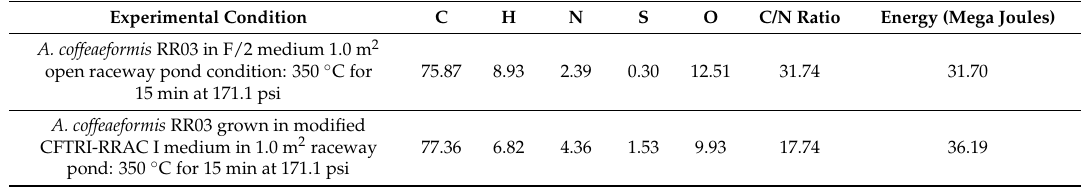
Table 4. Percentage of C, H, N, S, and O of bio crude of A. coffeaeformis RR03 under different